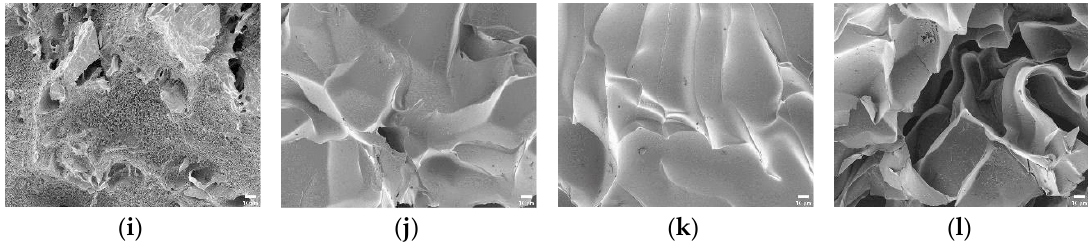
Figure 7. The FE-SEM images of polysaccharide-based SAPs ( × 1000, scale bar: 10 μm): ( a ) PS-CA0; ( b ) PS10-CA0; ( c ) PS20-CA0; ( d ) PS30-CA0; ( e ) PS-CA10; ( f ) PS10-CA10; ( g ) PS20-CA10; ( h ) PS30-CA10; ( i ) PS-CA20; ( j ) PS10-CA20; ( k ) PS20-CA20; ( l ) PS30-CA20.